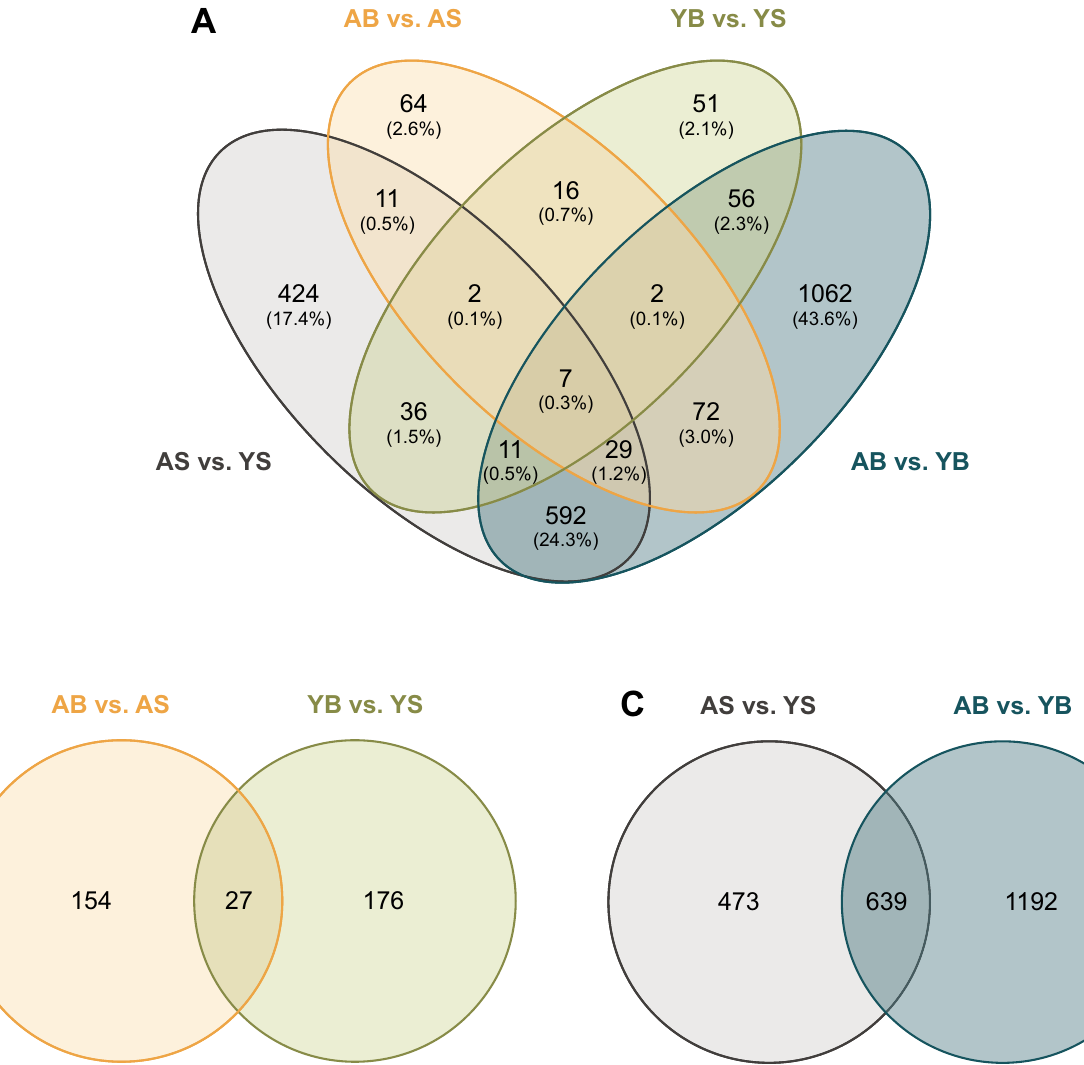
Figure 1. Venn diagram demonstrates the number of overlapped DEGs across burn injury and ages. ( A ) Comparisons between four groups, labeled as a young sham (YS), young burn (YB), adult sham (AS), and adult burn (AB). Four comparisons were colored in yellow (AB vs. AS), green (YB vs. YS), gray (AS vs. YS), and blue (AB vs. YB); ( B ) comparison between young burn and adult burn; ( C ) comparison between burn and